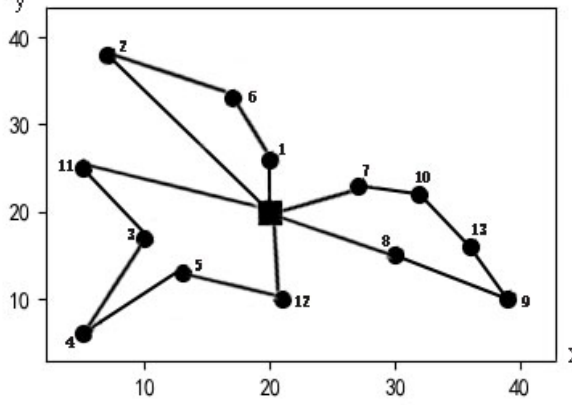
Figure 8. The road map of the final solution.